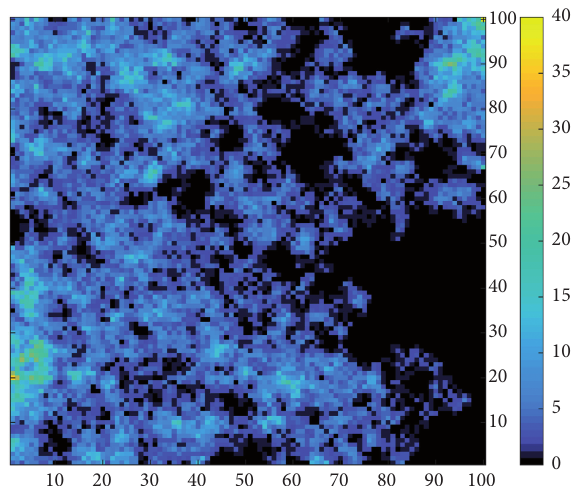
Figure 16: Grid coverage for 35,000 steps for motion in 4 directions.